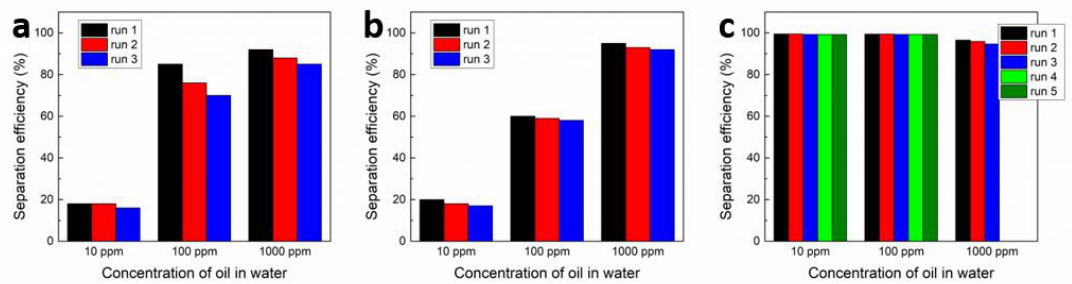
Figure 12. Separation efficiency of the coPA membranes with an ML-Ti 3 C 2 T x density coverage of ( a ) 0.89, ( b ) 1.77, and ( c ) 2.65 mg/cm 2 .